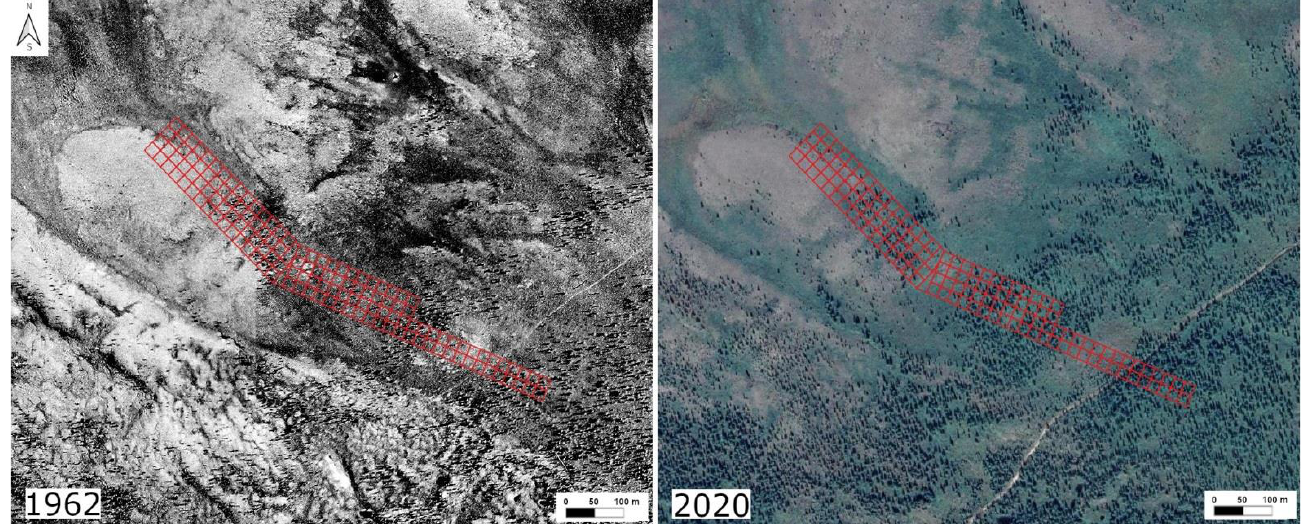
Figure 2. Aerial photo of 1962 and satellite image of 2020 indicating plot borders of altitudinal transects on the southeastern slope of a hill with a height mark of 312.8 m a.s.l., close to Mt. Chernaya (Polar Urals).